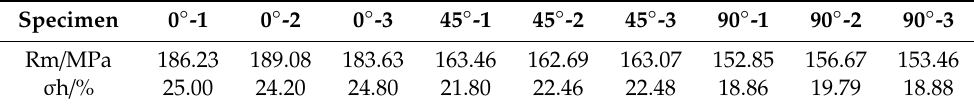
Figure 9. Stress-strain curves of the Ti/Al laminated composites obtained from the tensile test. Table 2. Mechanical properties of the Ti / Al laminated composites. Table 2. Mechanical properties of the Ti/Al laminated composites.